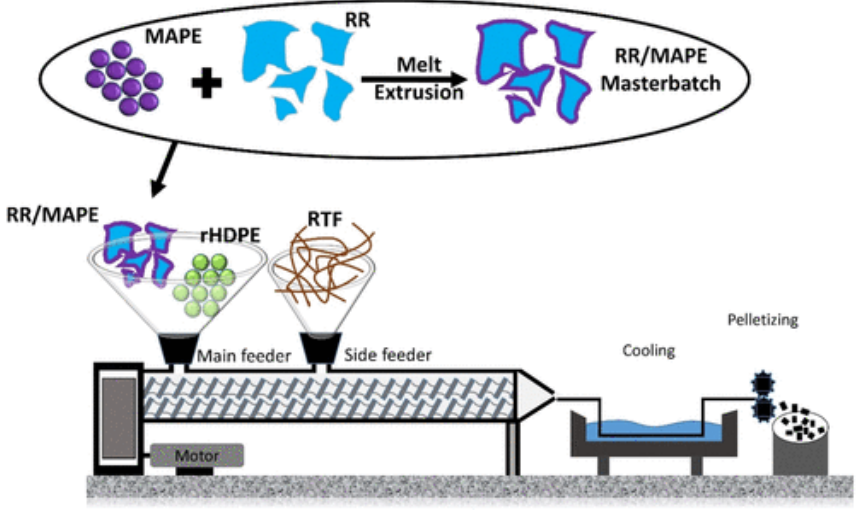
Figure 21. Melt extrusion steps for different rHDPE/(RR/MAPE)/RTF samples [44]. Table 5. Mechanical properties of the samples produced